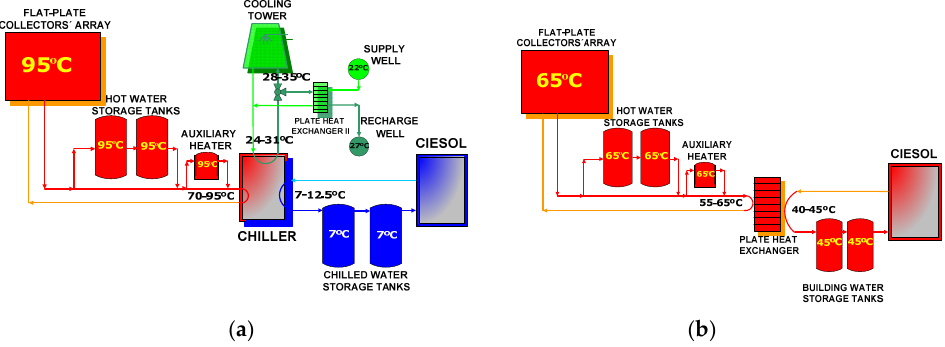
Figure 2. The general layout of the solar cooling and heating system (SCH) system installed at the Solar Energy Research Center (CIESOL), working in ( a ) the summer and ( b ) the winter season.